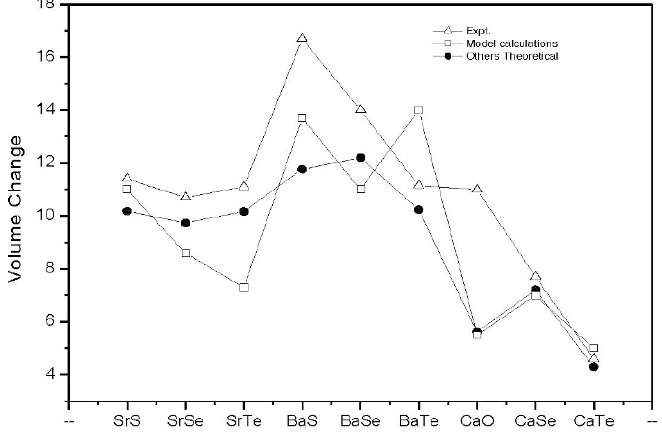
Figure 9. Volume collapse of alkaline earth chalcogenides.